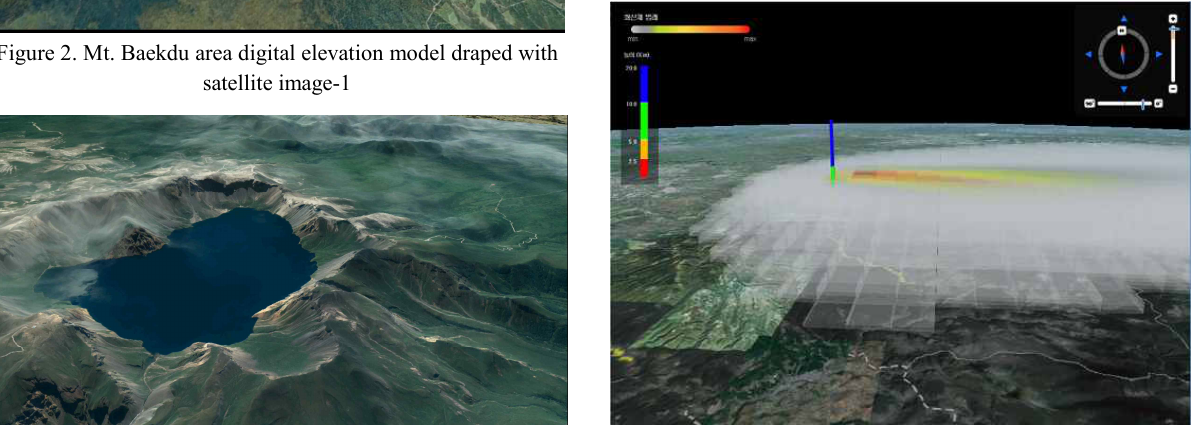
Figure 4. 3D visualization result with "Cube in the Air" method-1